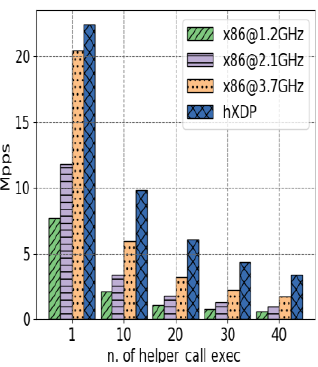
Figure 11. Forwarding output when calling a helper function.